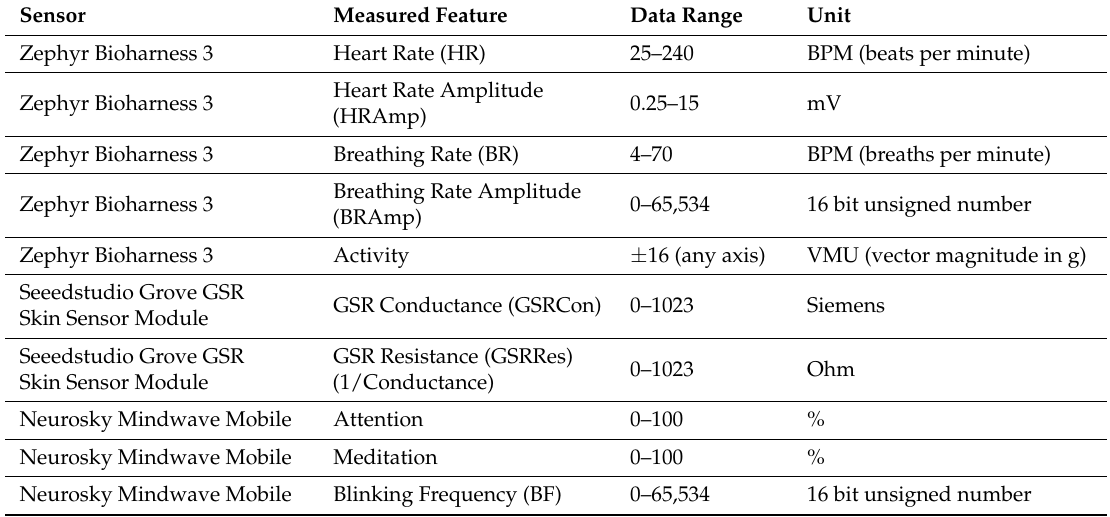
Table 1. List of measured psychophysiological features and sensors used.